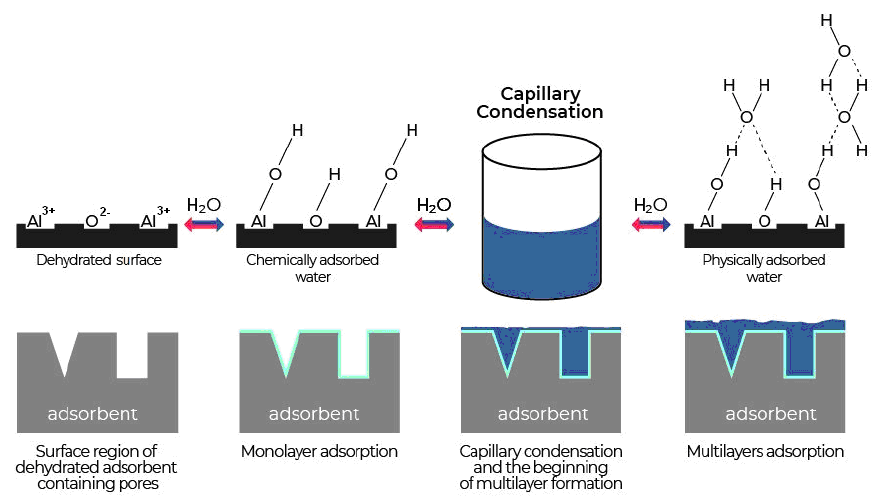
Figure 4. Stages of water vapour adsorption on aluminium oxide.